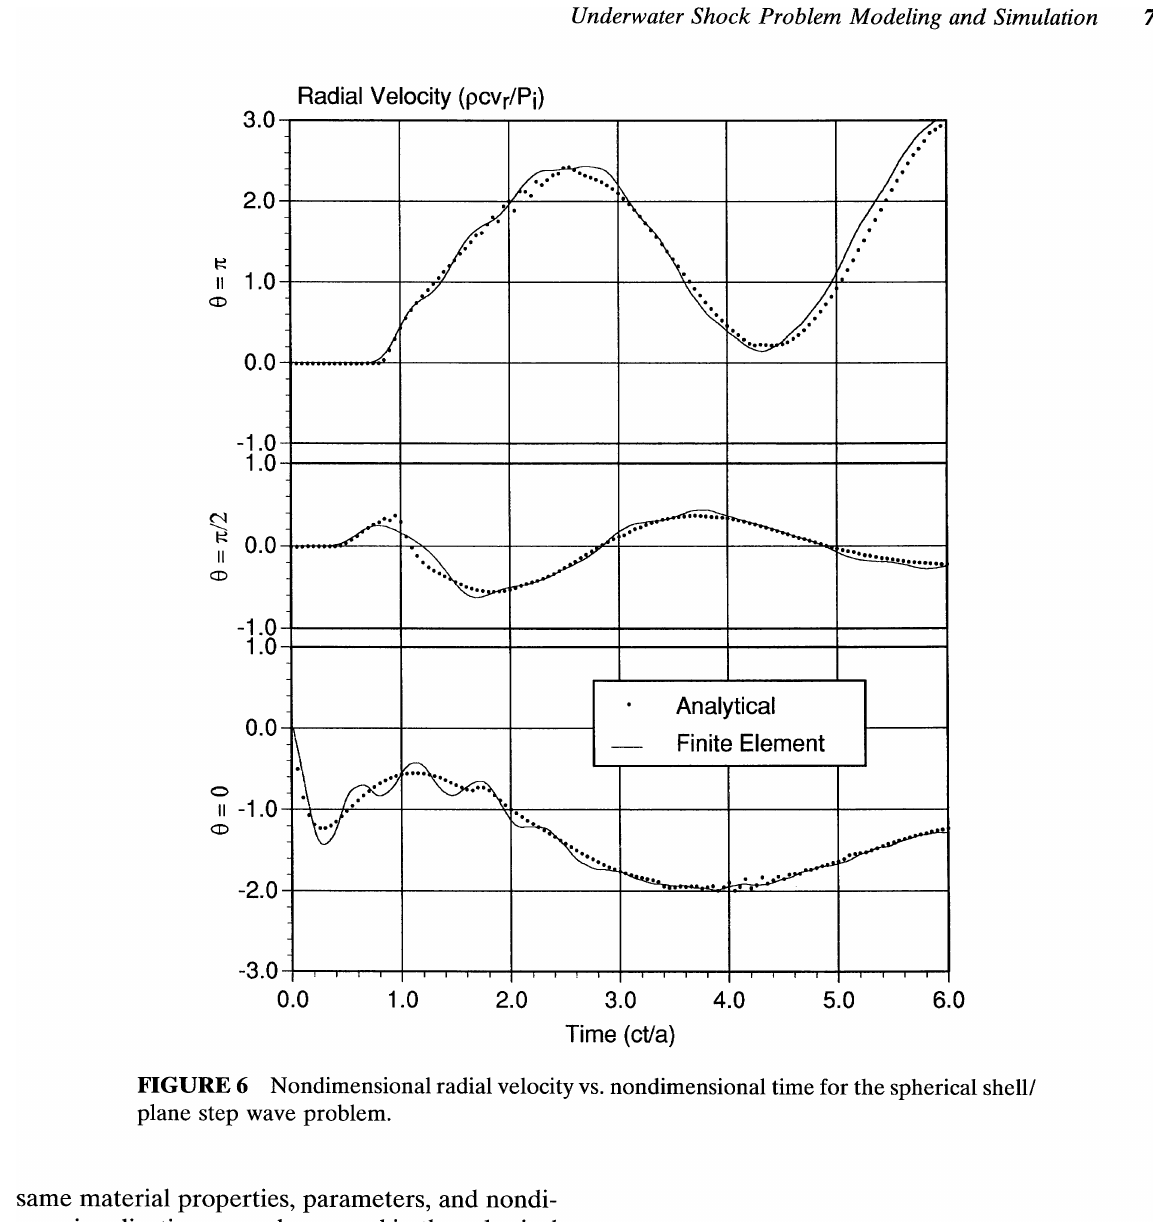
FIGURE 6 Nondimensional radial velocity vs. nondimensional time for the spherical shell! plane step wave problem.